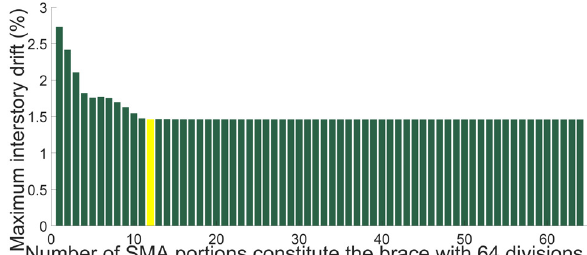
Figure 5: Maximum interstory drift of the three- story frames.